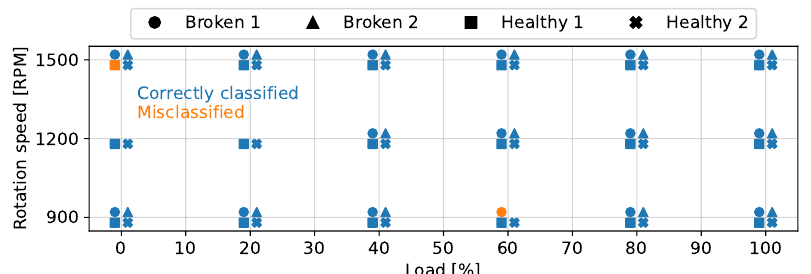
Figure 14. The results of the LR model used with the holdout test dataset shows which samples with different no-load rotation speeds and loads were classified